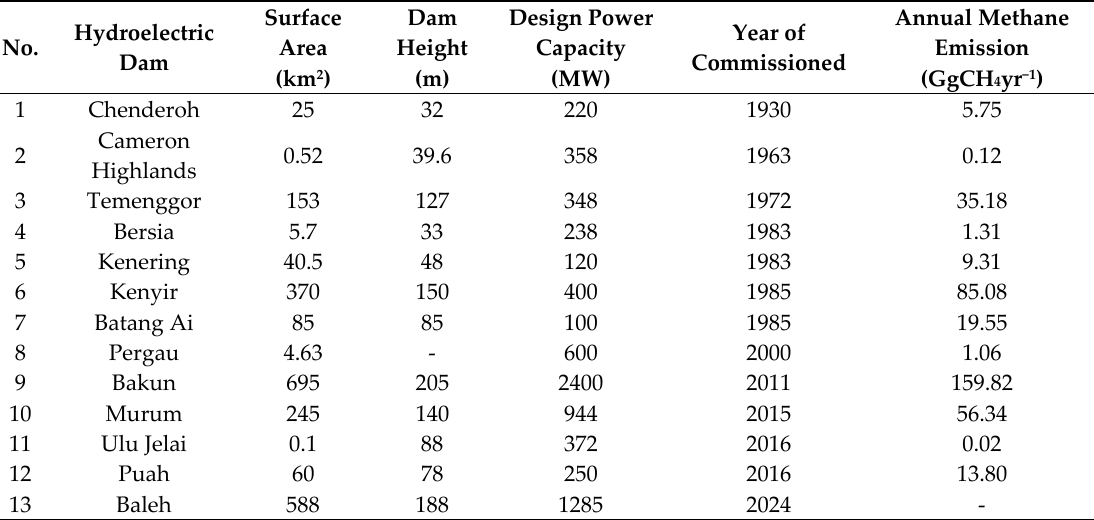
Table 2. List of major hydroelectric dams in